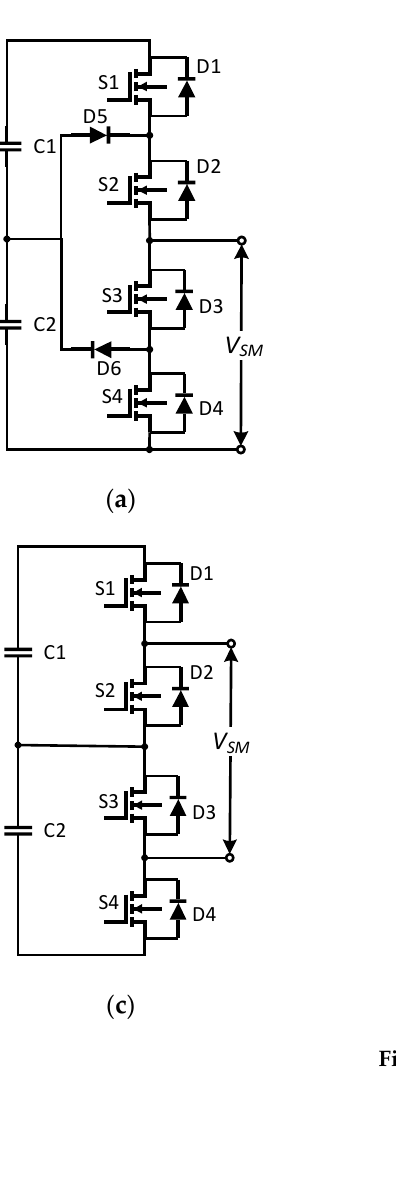
Figure 2. Two-level submodule topologies: ( a ) half-bridge submodule (HBSM); ( b ) current source HBSM; ( c ) full-bridge structure (FBSM); (d) self-balancing submodule (SBSM); ( e ) clamp-single submodule (CSSM) type- Ⅰ ; ( f ) CSSM type- Ⅱ ; ( g ) Single-thyristor HBSM; ( h ) Double-thyristor